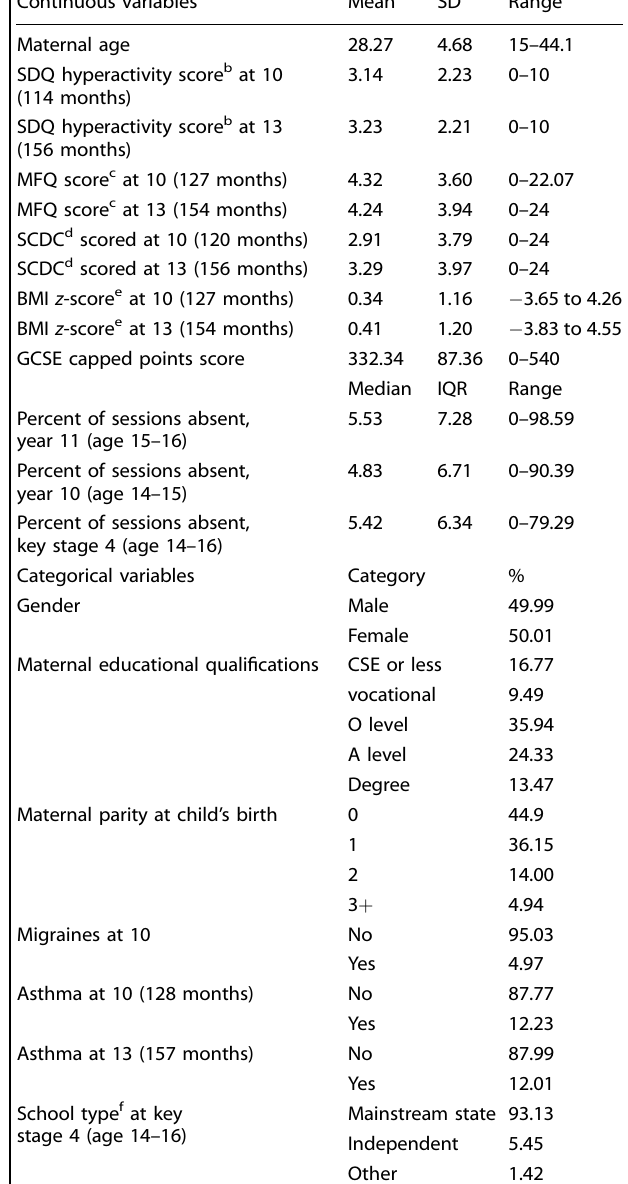
Table 1. Descriptive characteristics of analytic sample ( N = 6113) a